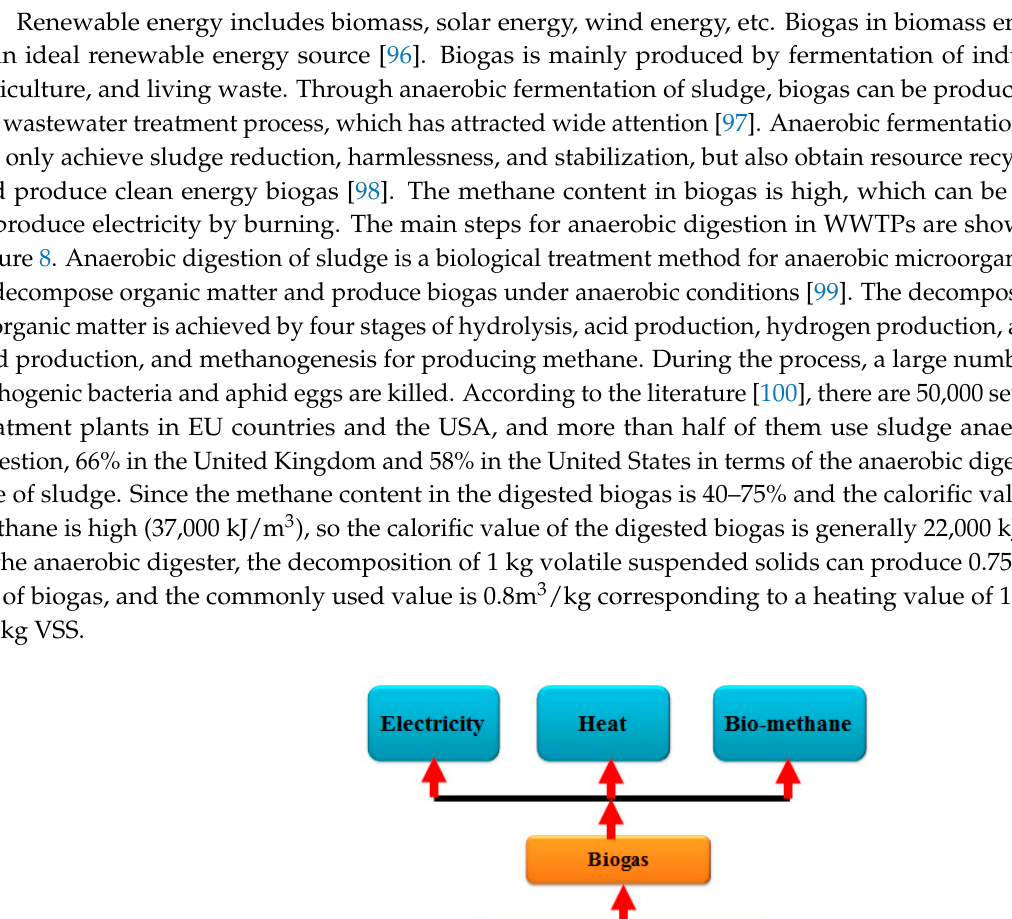
Table 1. The conventional utilization of digesting biogas.